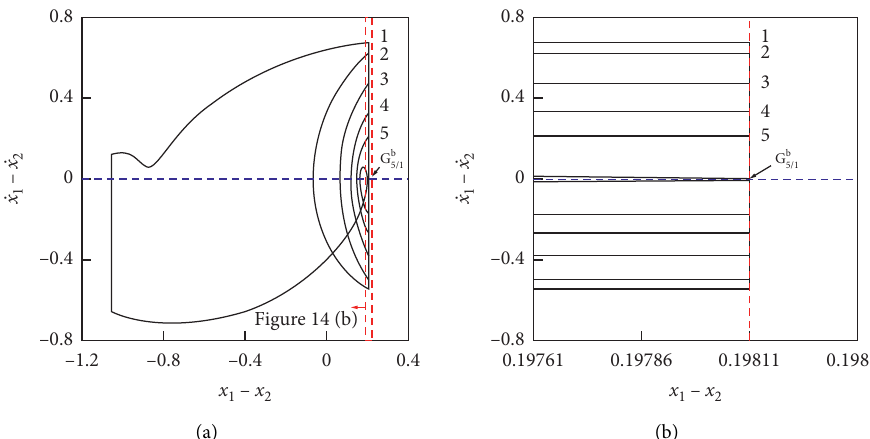
Figure 14: Phase diagrams at grazing bifurcation point G b Figure 14(a).